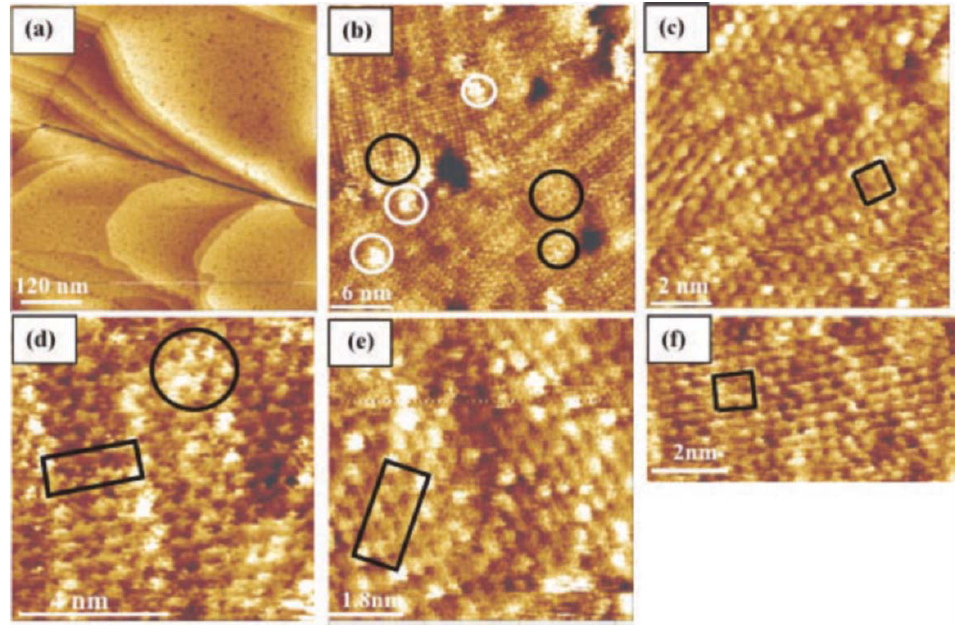
Figure 2. (a-d) Constant-current images for a Au(111)-substrate, which has been immersed for 24 h into 100 μM solution of BP2 in ethanol RT; (e-f) Constant-current images for a Au(111)-substrate, which has been immersed for 72 h into 100 μM solution of BP2 in ethanol RT. White circles in (b) confined regions showing the small elevated islands (height 2.5 Å) and black circles in (b) and (d) confined regions showing the clouds-like features. The unit cell of the (5 √ 3×3) structure is marked by the rectangular in (d) and (e). The unit cell of the rectangular (2 √ 3×3) structure is marked in (c) and (f). Tunneling parameters: (a) U= 950 mV; I= 450 pA, (b) U= 950 mV; I= 350 pA, (c) U= 550 mV; I= 130 pA, (d) U= 550 mV; I= 130 pA, (e) U= 530 mV; I= 150 pA, and (f) U= 530 mV; I= 150